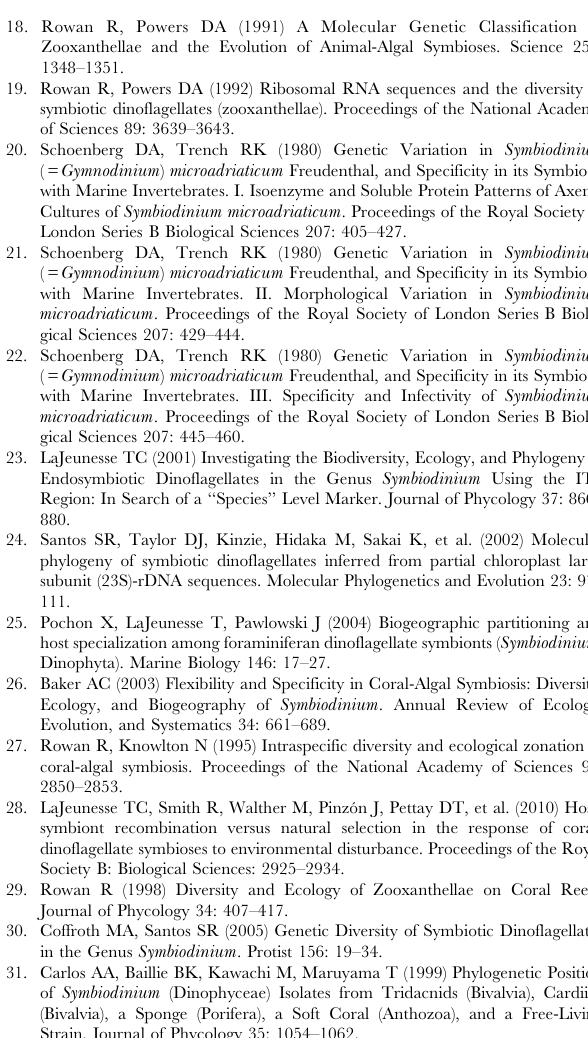
Figure S5 (A ) Authentic exon splice junction sequences for Symbiodinium clade B long sPCP genes align with potential exon splice junctions in other Suessiales, Gonyaulacales and Gynnodi- niales taxa. ( B ) Likewise, the authentic exon splice junction sequence for Symbiodinium microadriaticum short sPCP genes aligns with potential exon splice junctions in other isolates from the Suessiales and Peridiniales. Authentic exon splice junction sequences are bold and enclosed within rectangles. Intron insertion positions are marked with ‘‘ Q ’’. Potential exon splice junction sequences are bold with double underlines for exact matches to authentic junctions or single line for match to other splice site motifs. Figure S6 Dotplots that compare predicted short and long sPCP mature apoprotein amino acid sequences. ( A)